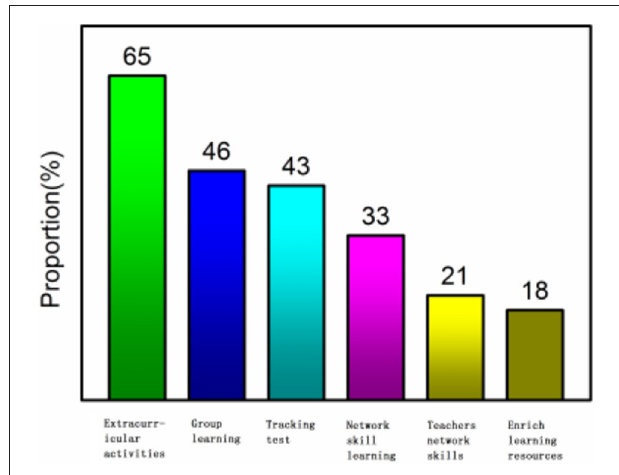
FIGURE 5 | Statistics of